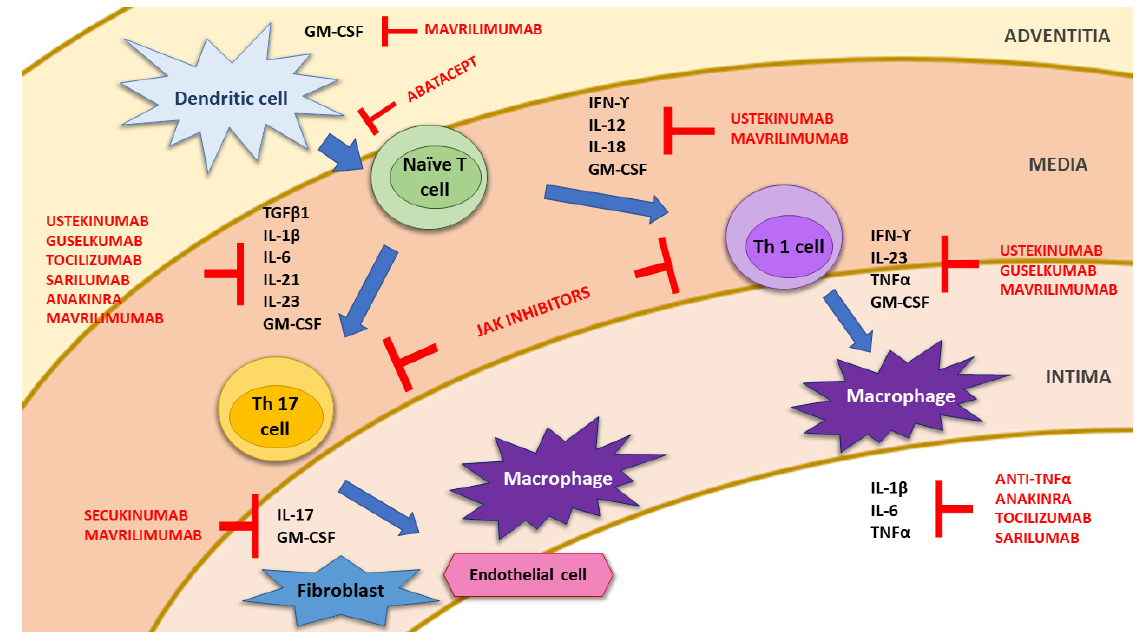
Figure 1. Schematic representation of the pathophysiology of giant cell arteritis. Abbreviations: GM-CSF: granulocyte-macrophage colony-stimulating factor; IL: interleukin; INF- Υ : interferon gamma; JAK: Janus kinase; T cell: T lymphocytes; Th: T helper lymphocytes subpopulation; TGF- β : transforming growth factor beta; TNF- α : tumor necrosis factor alpha.